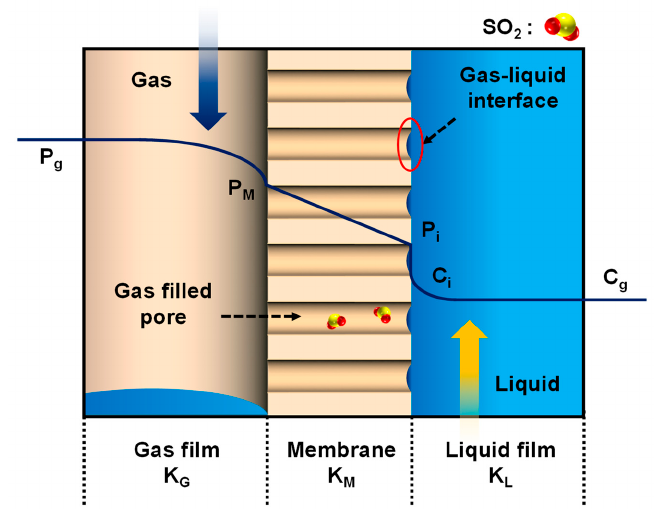
Figure 2. Mass transfer in hollow fiber membrane contactor. P g , P m , and P i represent the partial pressure at the interface between the gas, the membrane, and the gas–liquid phase, respectively.